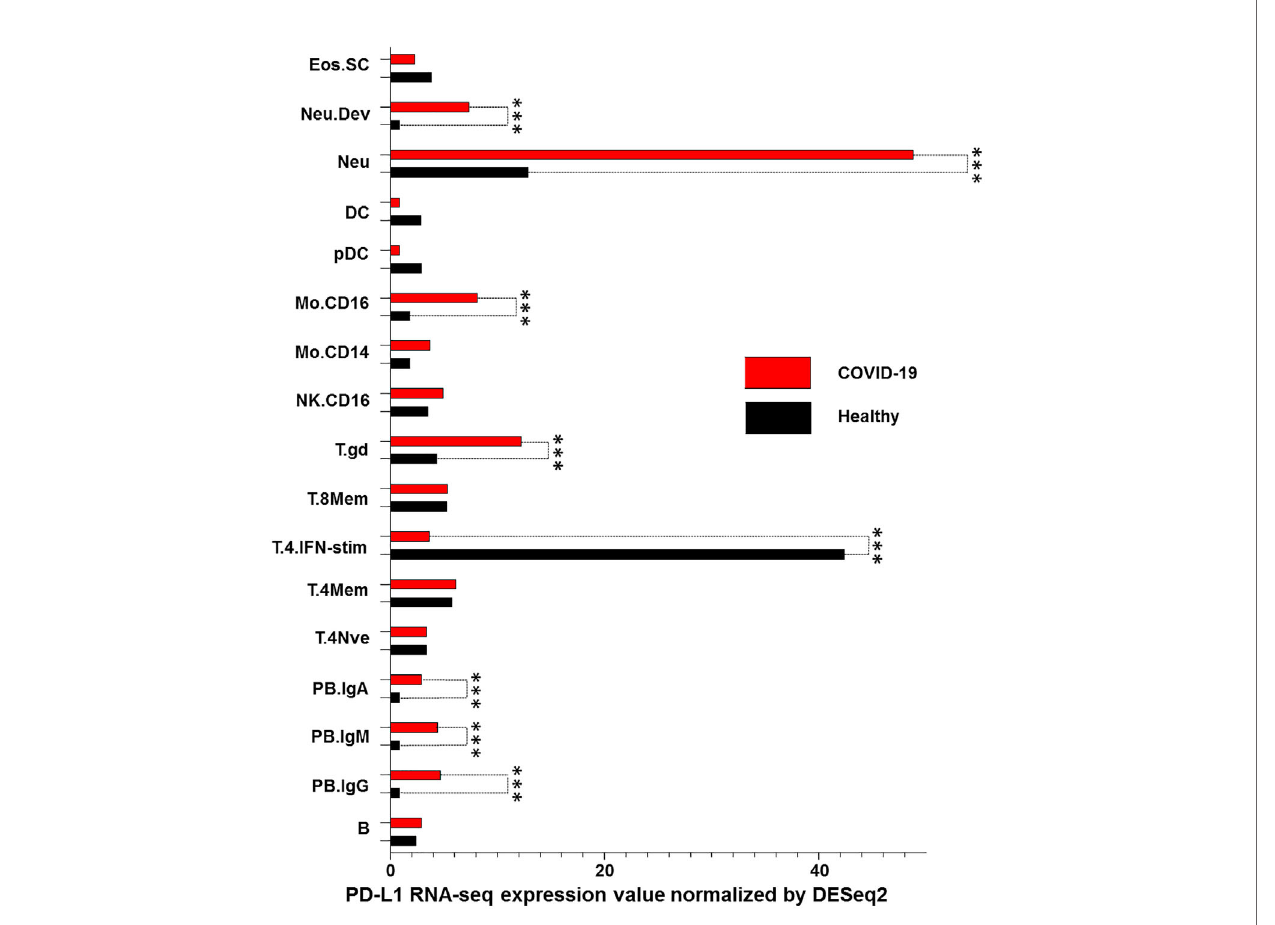
FIGURE 5 | PD-L1 dysregulation in PBMC of COVID-19 patients. RNA levels of PD-L1 in PBMCs derived from COVID-19 patients and healthy donors were down- loaded from the Immunological Genome Project database and analyzed. PBMC were characterized as stem cells and eosinophils (Eos.SC), developing neutrophils (Neu.Dev), neutrophils (Neu), dendritic cells (DC), plasmacytoid dendritic cells (pDC), monocytes CD16+ and CD14+ (Mo.CD16 and Mo.CD14), natural killer cells (NK), gamma delta T cells (T.gd), CD8+ memory T cells (T.8Mem), CD4+ interferon-stimulated T cells (T.4.IFN-stim), CD4+ memory T cells (T.4Mem), CD4+ naive T cells (T.4Nve), IgA+ plasmablasts (PB.IgA), IgM+ plasmablasts (PB.IgM), IgG+ plasmablasts (PB.IgG) and B cells (B). RNA levels of PD-L1 for all cell types with the control were compared using Pairwise comparisons. *** indicate p <